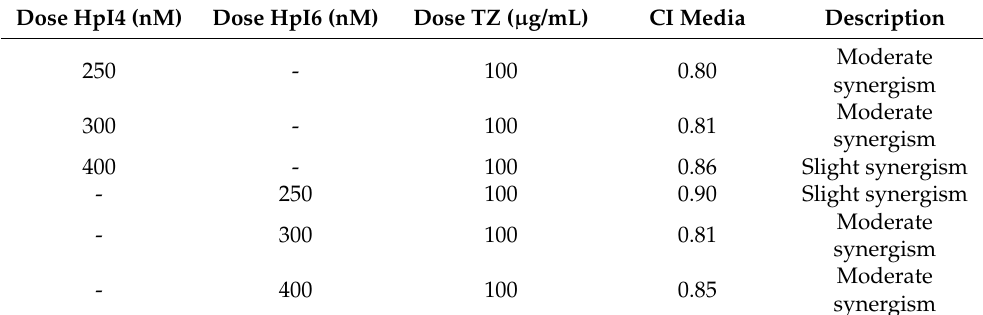
Table 2. Analysis of synergy for the combinations of PPRHs and trastuzumab in MDA-MB-453 cells. Dose HpI4 (nM) Dose HpI6 (nM) Dose TZ ( µ